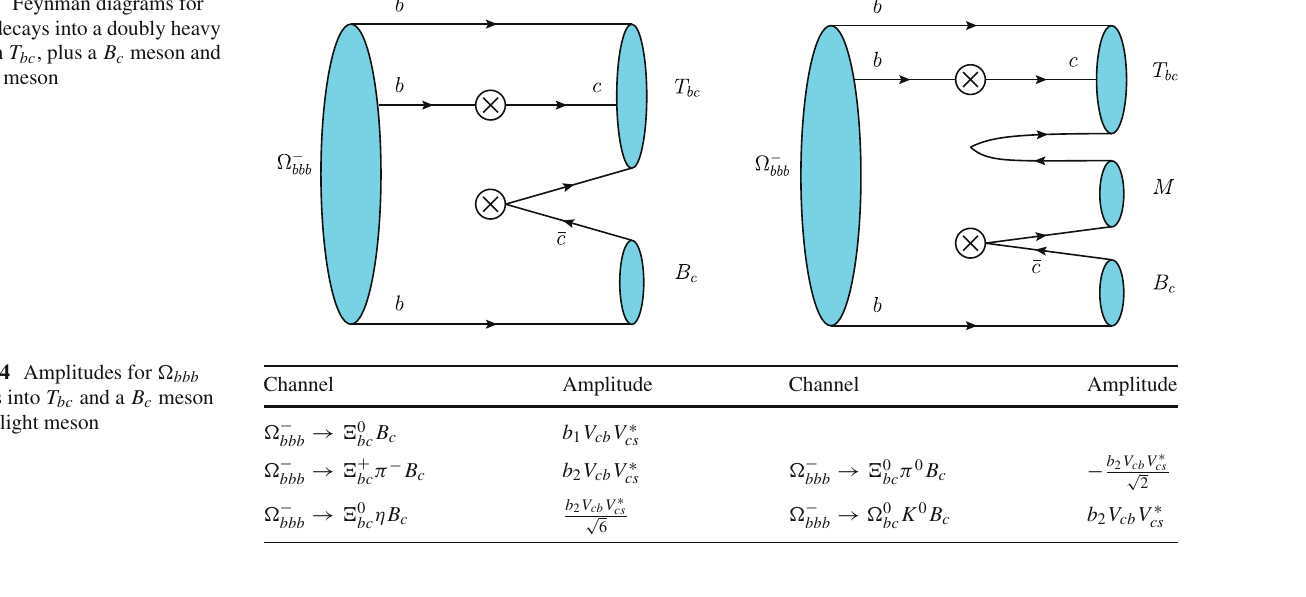
Fig. 3 Feynman diagrams for (cid:2) − decays into a doubly heavy bbb baryon T bc , plus a B c meson and a light meson